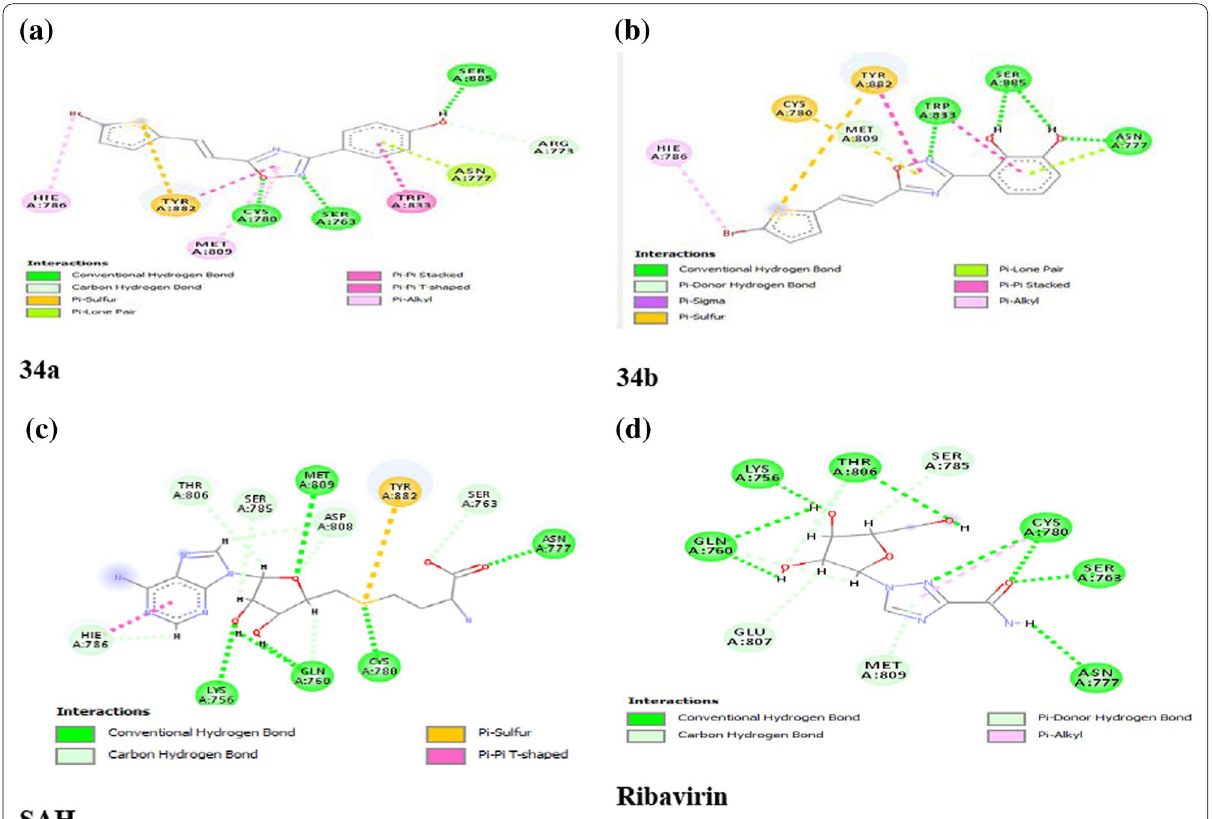
Fig. 3 2D docking interaction of some selected design compounds (34a and 34b) ( a , b ) and standard inhibitors (SAH and Ribavirin) ( c , d ) with the DENV NS-5 protease (PDB ID: